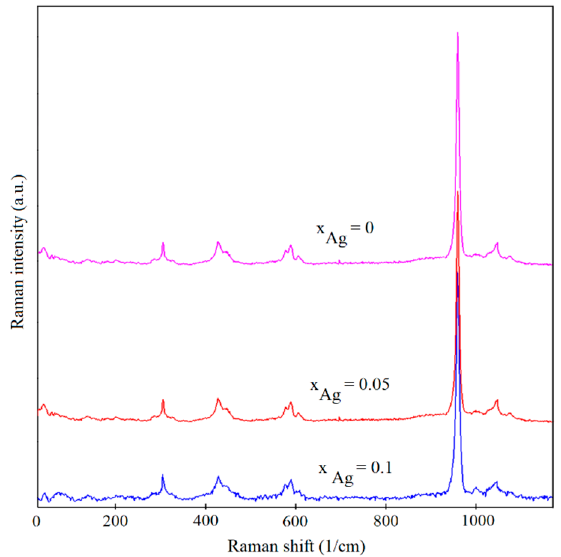
Figure 7. Raman spectra obtained on silver doped hydroxyapatite thin films (x Ag = 0; 0.05 and 0.1).